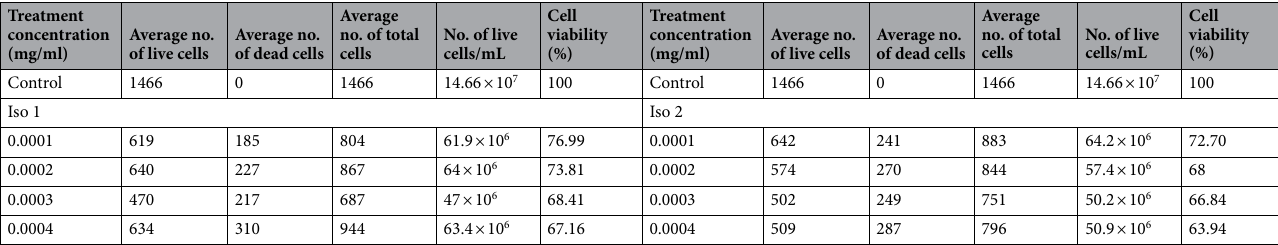
Table 6. Anti-proliferative activity of Iso 1 and Iso 2 in the yeast cell